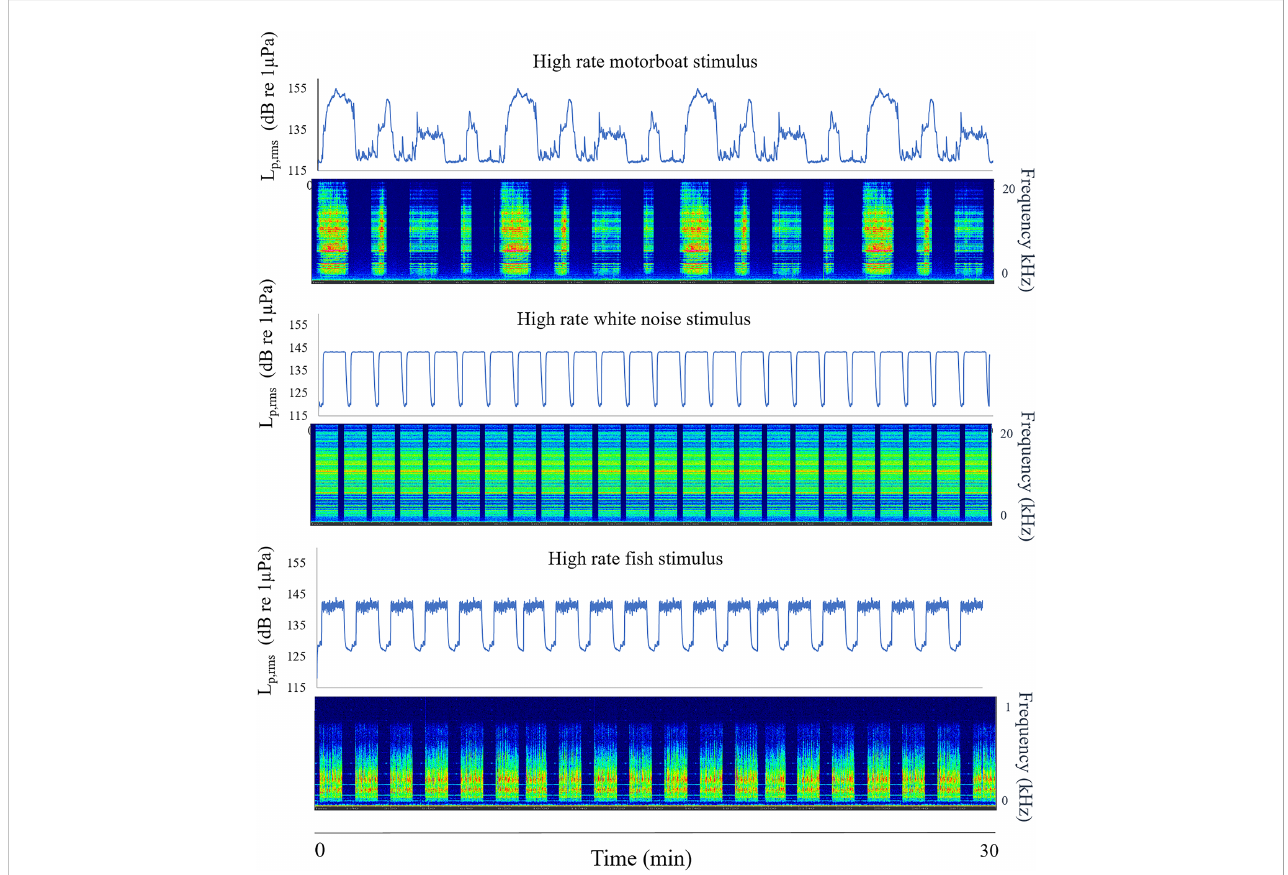
FIGURE 1 Spectrograms and sound pressure level (L p , rms dB re 1µPa) of 30 min duration of a playlist example of the different stimuli: motorboat, white noise and fi sh (8192 samples of FFT size, Hann window and signal superposition of 50%, Linear frequency